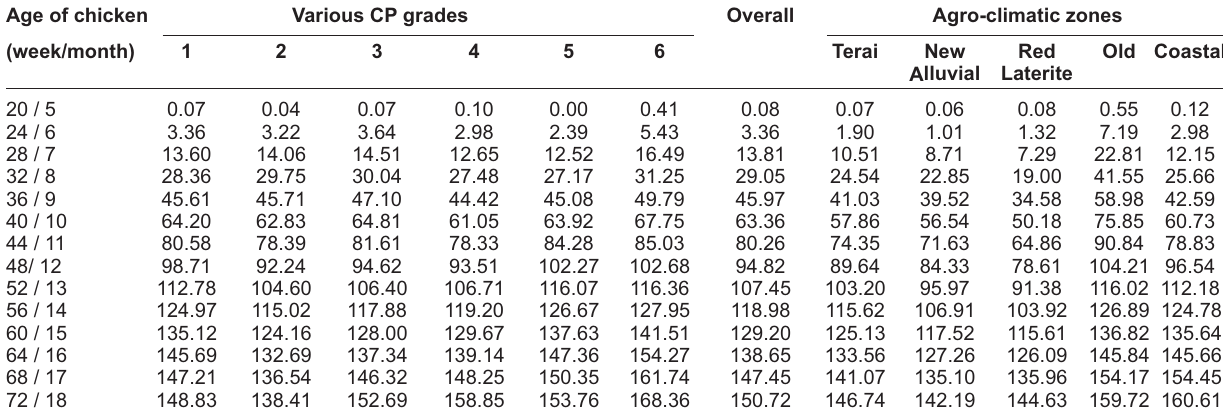
Table-3: Age wise egg production performance of RIR reared at backyard in different agro-climatic zones of West Bengal, India using initial supplied feed followed by feed used in farming practices. Age of